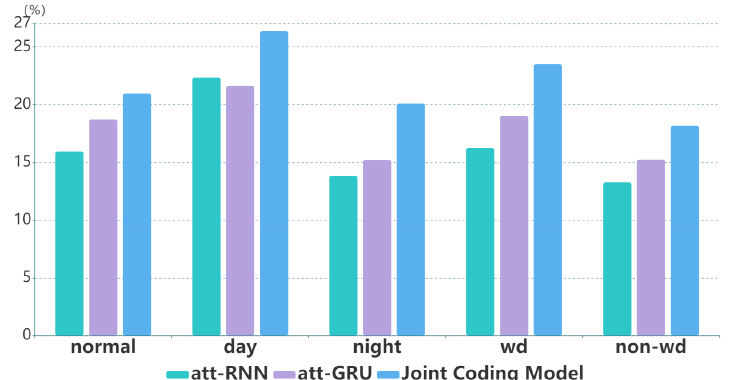
Figure 5. The MRR@20 of different groups in experiment 1.